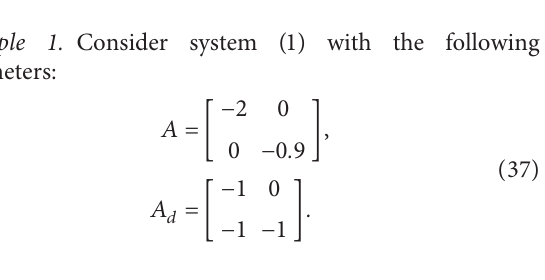
2 ( t ) for different h 1